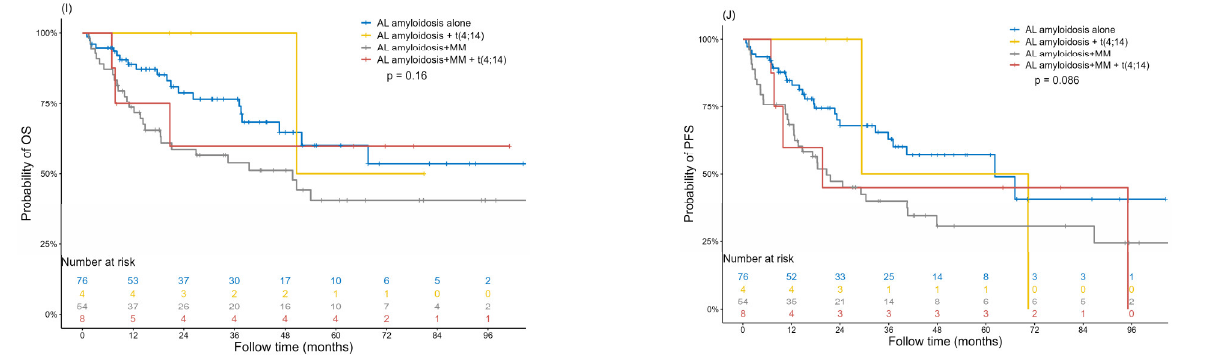
Figure 2. Kaplan–Meier curves. Overall survival ( A ) and progression-free survival ( B ) of AL amyloidosis patients with or without concurrent MM. Overall survival ( C ) and progression-free survival ( D ) of AL amyloidosis patients with or without concurrent MM, according to the presence or absence of t(11;14). Overall survival ( E ) and progression-free survival ( F ) of AL amyloidosis patients with or without concurrent MM, according to the presence or absence of 1q21 gain. Overall survival ( G ) and progression free survival ( H ) of AL amyloidosis patients with or without concurrent MM according to the presence or absence of 13q-; Overall survival ( I ) and progression free survival ( J ) of AL amyloidosis patients with or without concurrent MM according to the presence or absence of t(4;14). Abbreviations: AL, amyloid light chain; MM, multiple myeloma;13q-, 13q deletion.